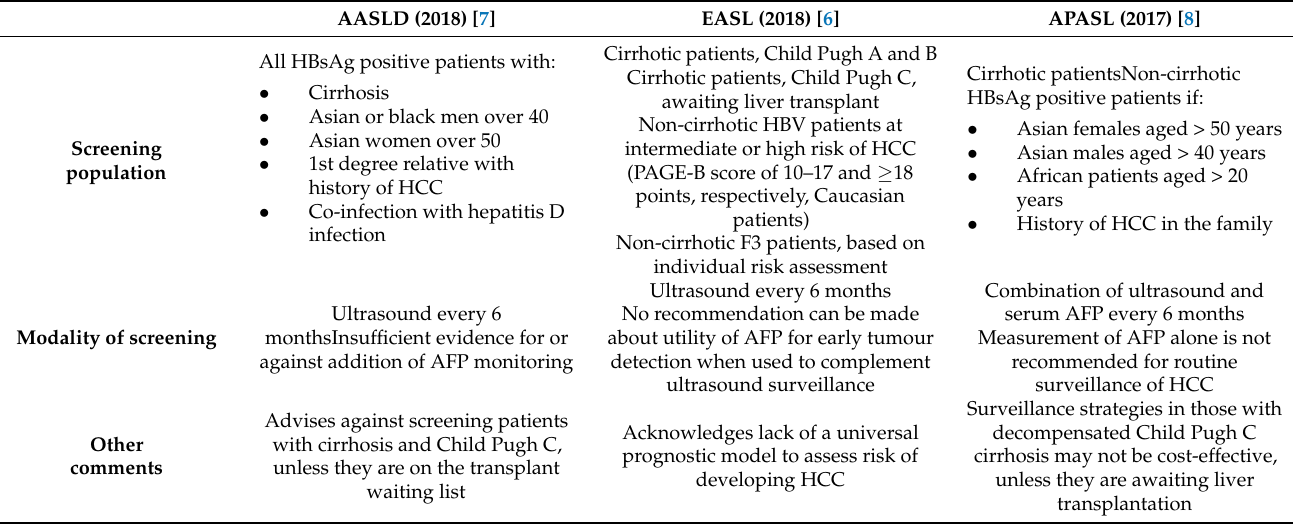
Table 1. Comparison of international guidelines for HCC surveillance in patients with chronic hepatitis B